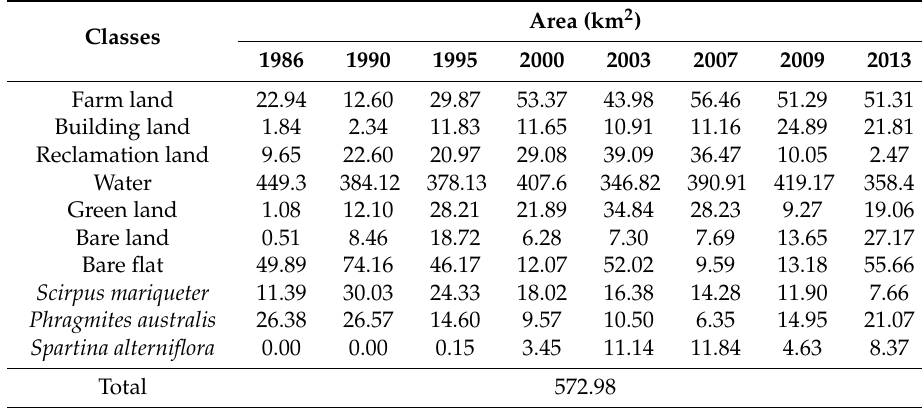
Table 4. Area statistics of ten classes ( Spartina alterniflora was introduced into Chongming Island after 1995).